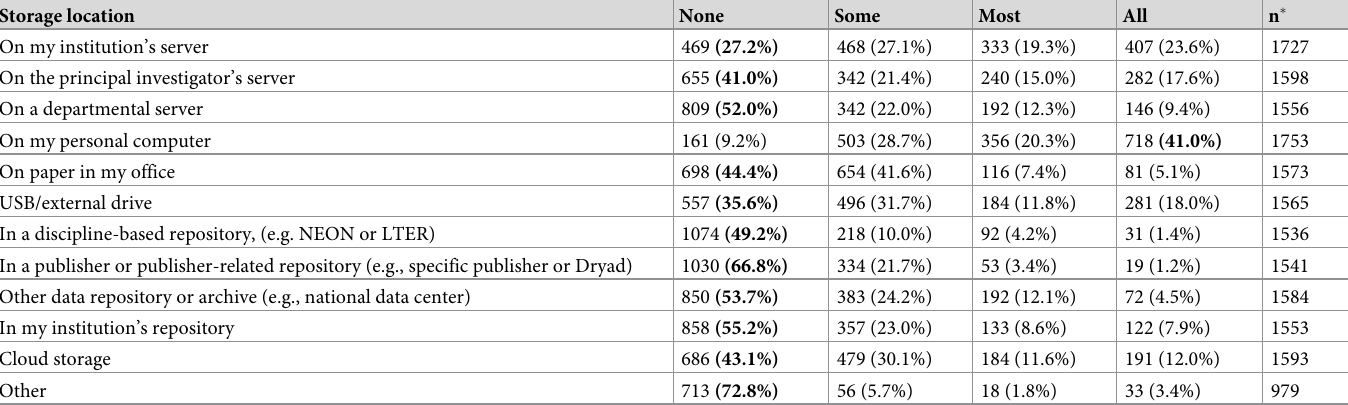
Table 2. “How much of your data do you currently store or deposit in the following locations?”. (This is a combined number of the respondents who store most or all of the data in the specified location. Each response option was coded as a separate question, since the respondents may store data in various locations simultaneously, and answer “Not sure” is omitted from the